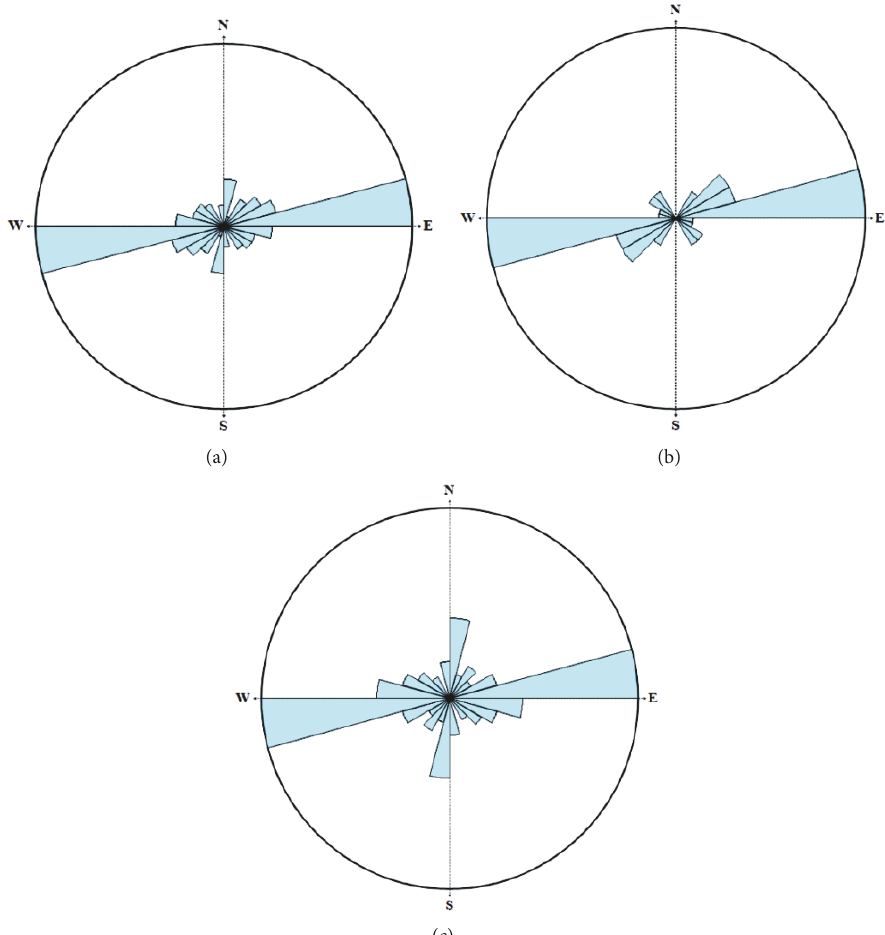
Figure 11: (a) Rose diagram of the general lineament orientations of the area studied; (b) rose diagram of the major lineament orientations; (c) rose diagram of the minor lineament